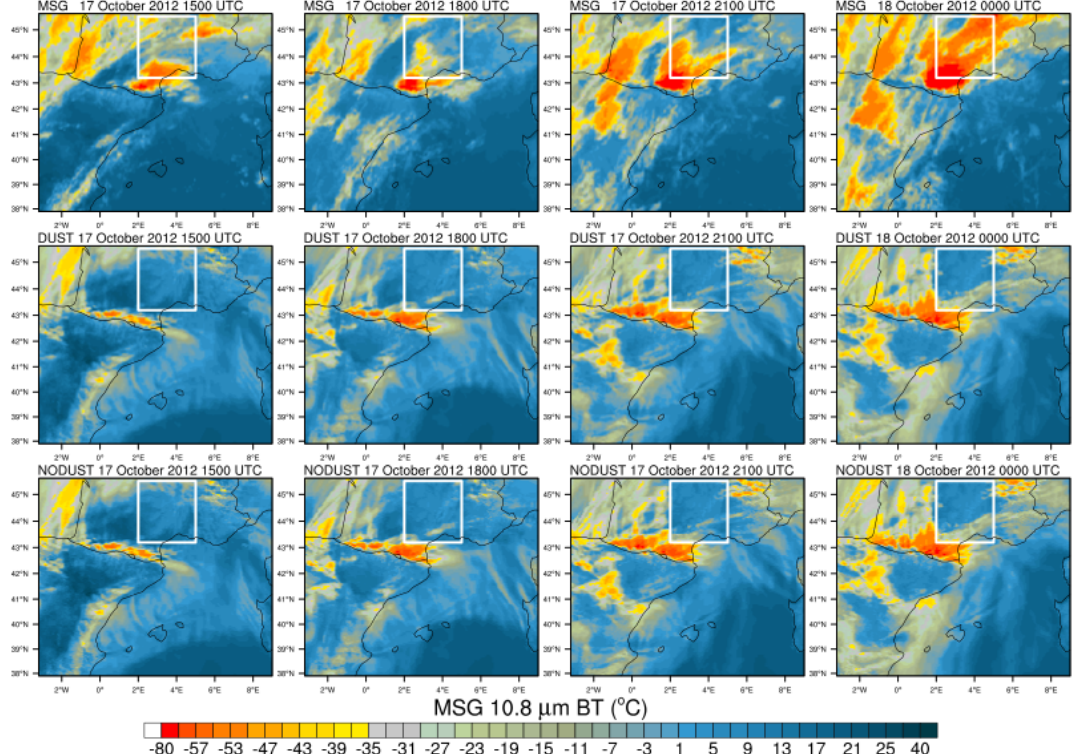
Figure 11. Top panels: 3-hourly field of BT at 10.8µm between 15:00UTC on 17 October and 00:00UTC on 18 October 2012. Middle panels: same as top panels but for BT extracted from DUST. Bottom panels: same as middle panels but for BT extracted from NODUST. The white box shows the CV